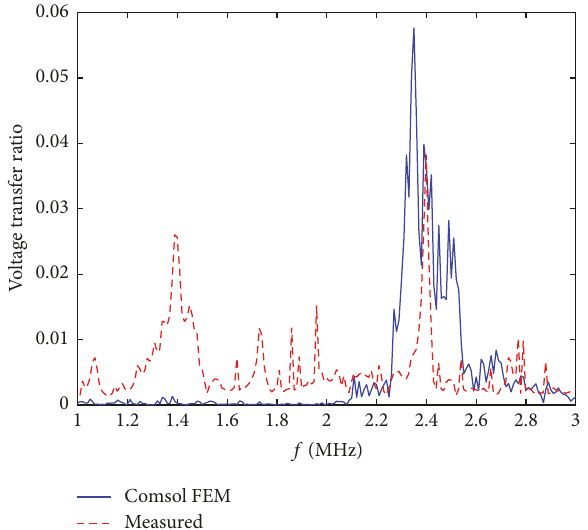
Figure 16: Output-to-input voltage transfer ratio of the channel through a cylindrical metal pipe.